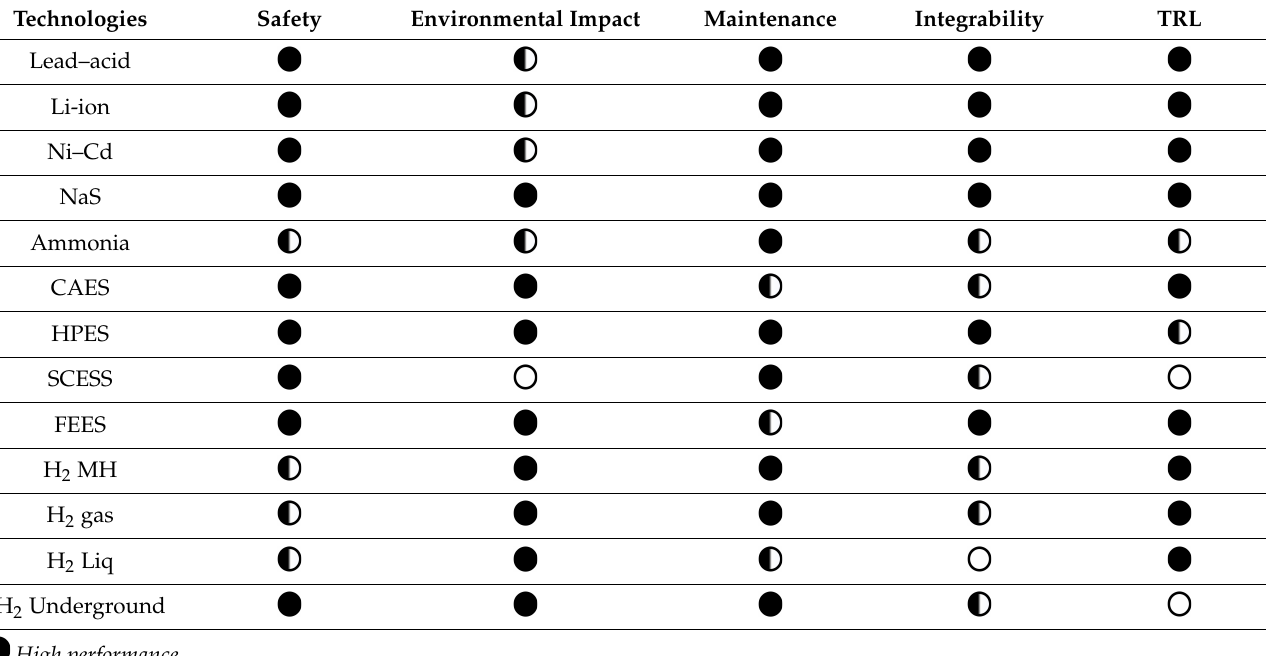
Table 4. Qualitative performance of energy storage technologies based on the literature in Table